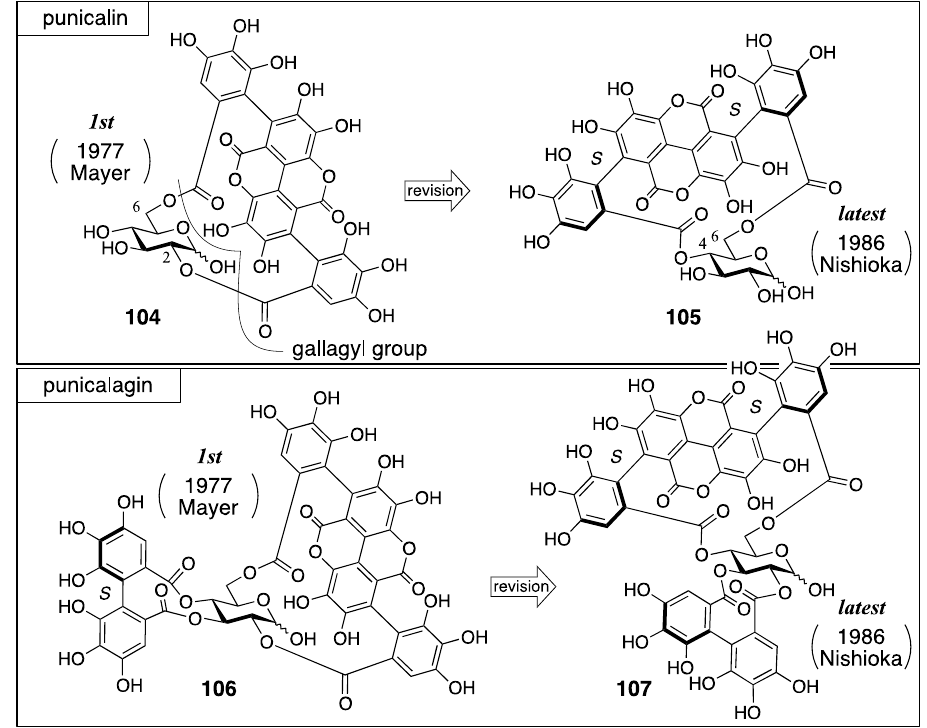
Figure 40. The transition of the structures of punicalin and punicalagin.